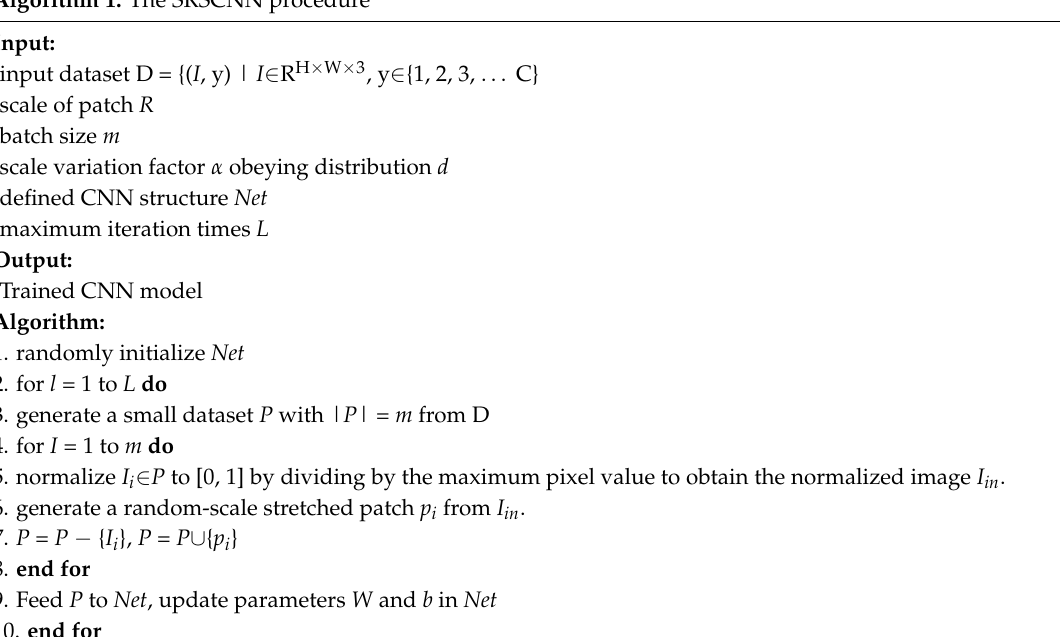
Algorithm 1. The SRSCNN